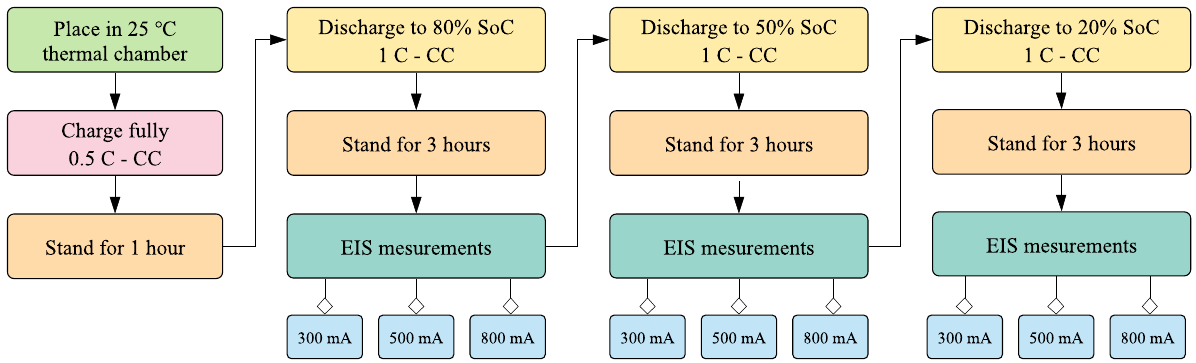
Figure 1. The flow chart for EIS measuring process of lithium-ion batteries under each condition.